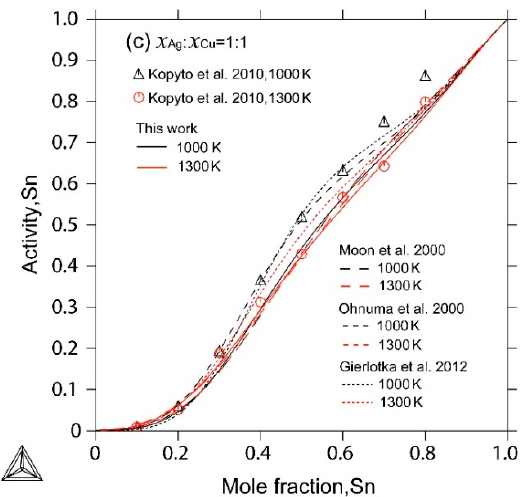
Figure 8. Comparison of the calculated activities of Sn in liquid ternary alloys with the experimental data from [31] and the calculated results from [21,24,28] at 1000 K and 1300 K (referenced states: liquid Ag, liquid Cu and liquid Sn). ( a ) x Ag : x Cu = 1 : 3; ( b ) x Ag : x Cu = 3 : 1; ( c ) x Ag : x Cu =